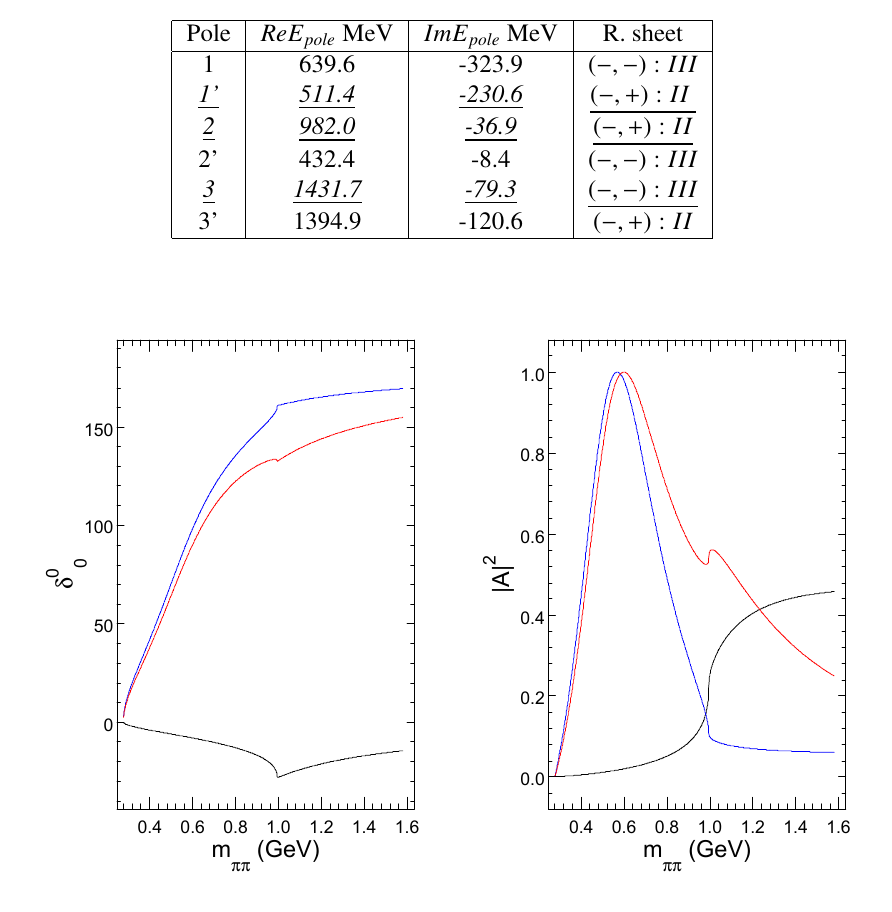
Figure 3. Phase shifts and squared modules of amplitudes produces by single poles from Table 1 and their pairs, black lines are for pole 1, blue for 1’ and red for both poles